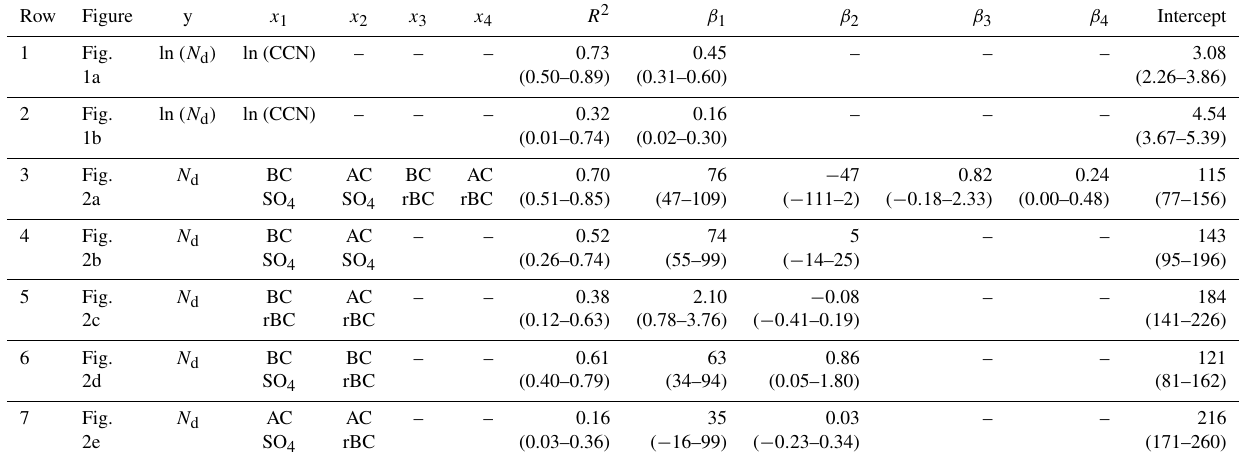
Figure 1. Scatterplots of N d against (a) below-cloud and (b) above-cloud CCN concentration from all ORACLES-2016 flights. Solid and dashed purple lines show the mean value and 95% confidence interval of g , respectively. Table 1. Coefficient of determination ( R 2 ) , regression coefficients ( β) , and intercepts for all OLS regressions. Values reported as means with the 95% confidence interval in parentheses as determined via